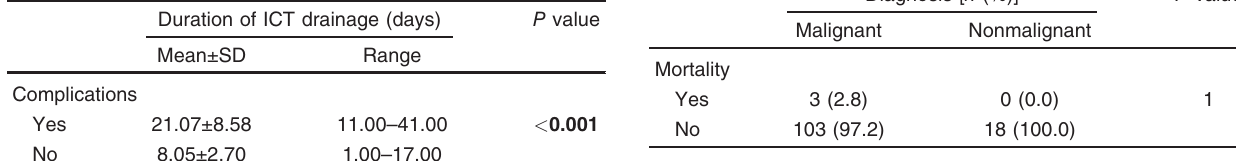
Table 3 Relation between complications and duration of drainage of ICT